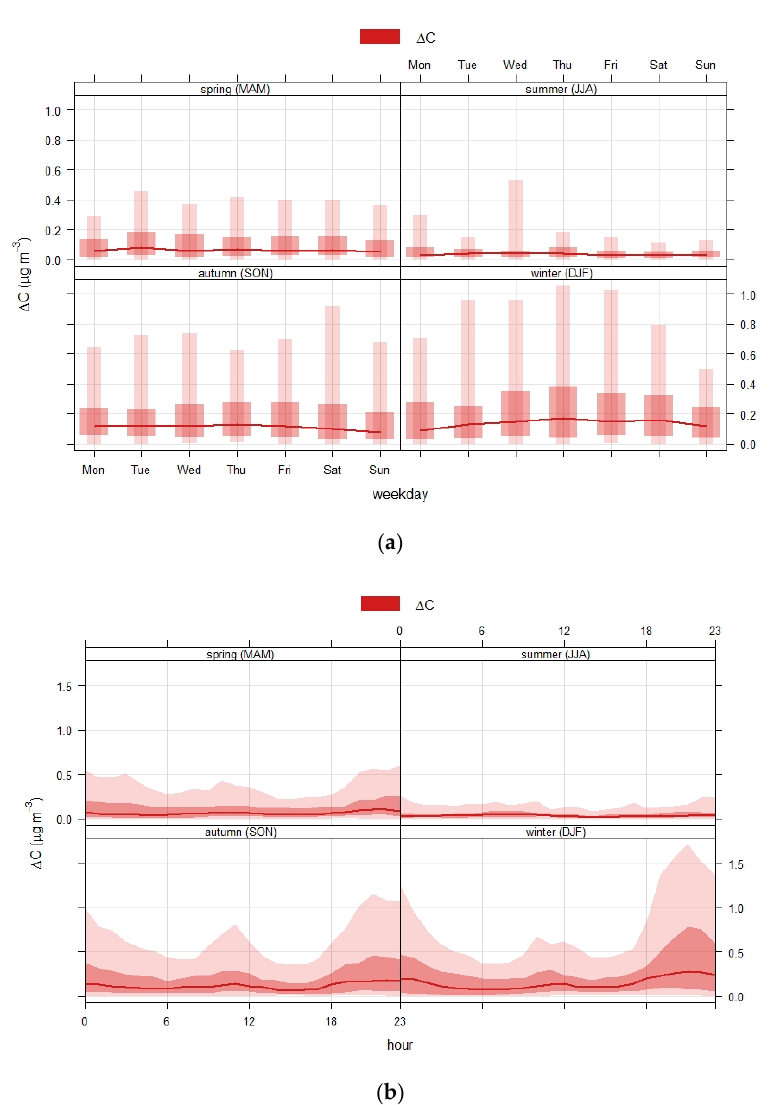
Figure 5. ( a ) Day of the week variation of median enhanced absorption ( Δ C) concentrations. ( b ) Hour of day variation of median Δ C concentrations. The shading shows the extent to the 25/75th and 5/95th quantiles.